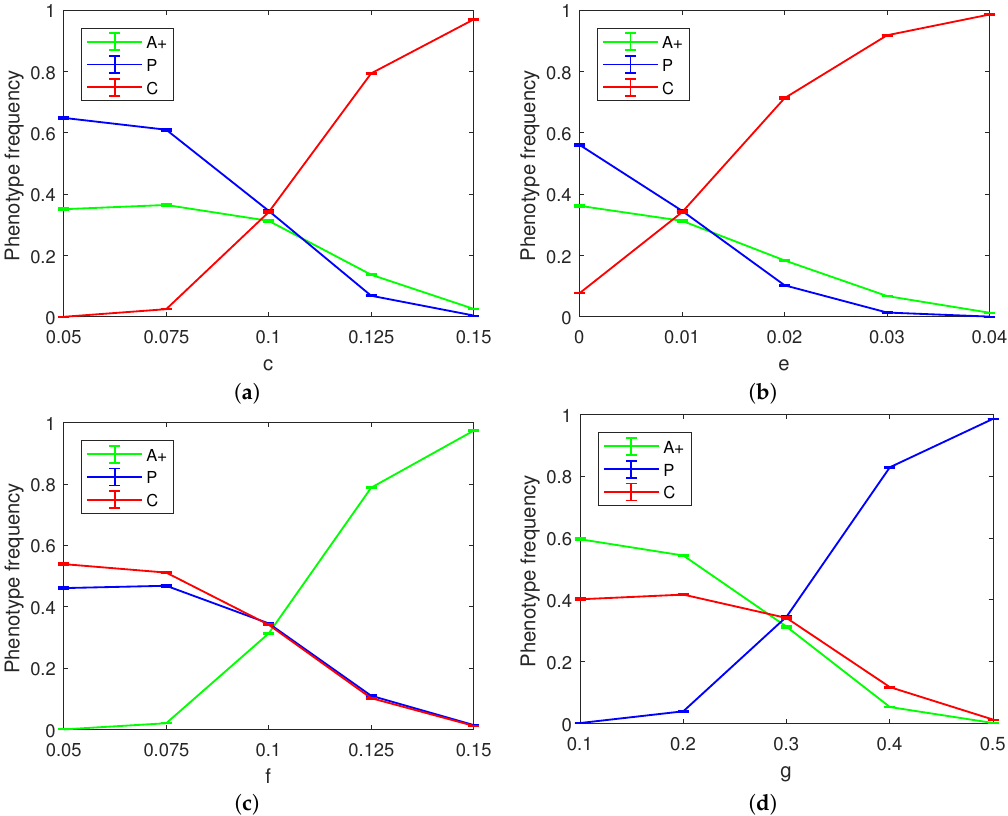
Figure 5. Final phenotype frequency distribution in the spatial game for various parameter combinations. All parameters except the focal one are fixed at the following values: a = b = c = d = f = 0.1, e = 0.01, g = 0.3. ( a ) cost of exposure to cytotoxins; ( b ) exploitation benefit for cytotoxic cells; ( c ) synergistic activity among angiogenesis-factor producing cells; and ( d ) proliferative cell reproductive